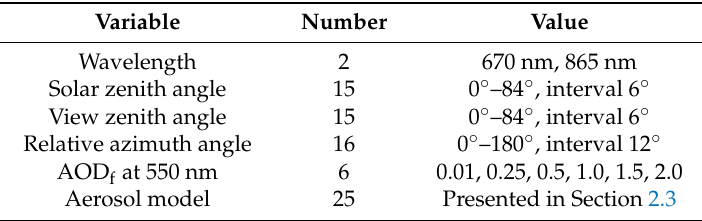
Table 1. Dimensions of LUT for AODf